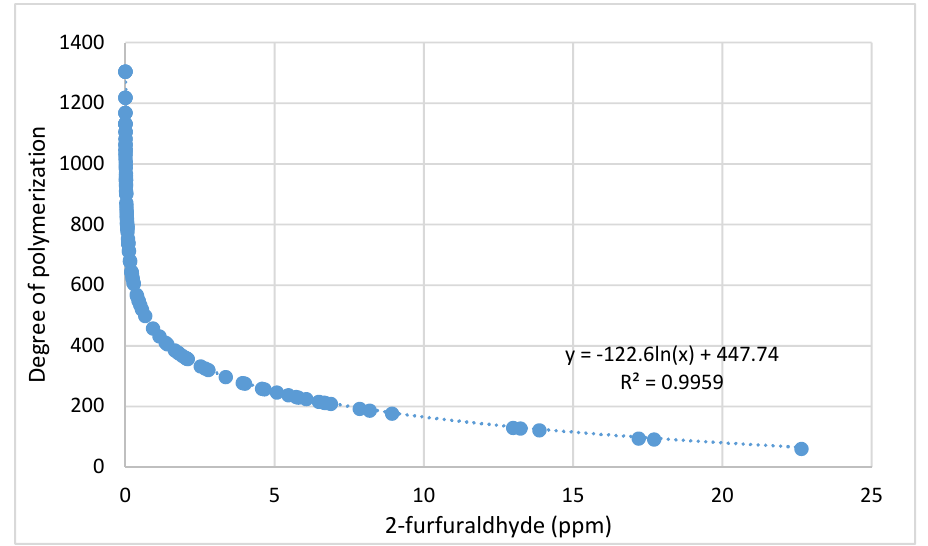
Figure 6. The fitting expression between PD and FA (ppb).